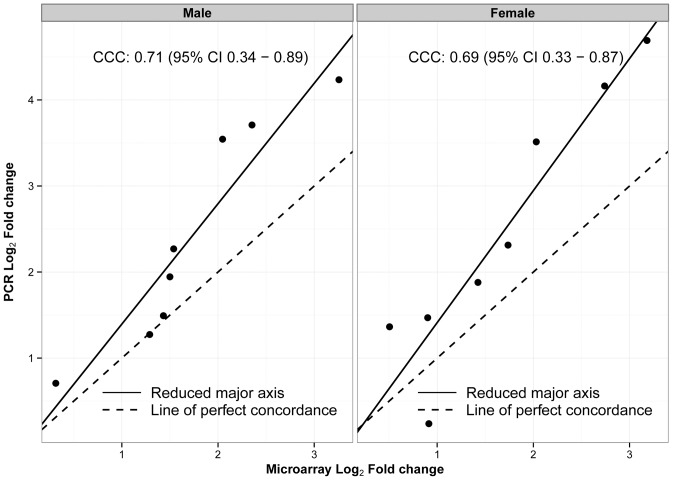
Concordance correlation coefficient (CCC) between qPCR and microarray results.Used to measure the agreement between the log2 FC results from qRT-PCR and microarray in both males and females. The dashed line represents the line of perfect concordance. The solid line represents the reduced major axis.